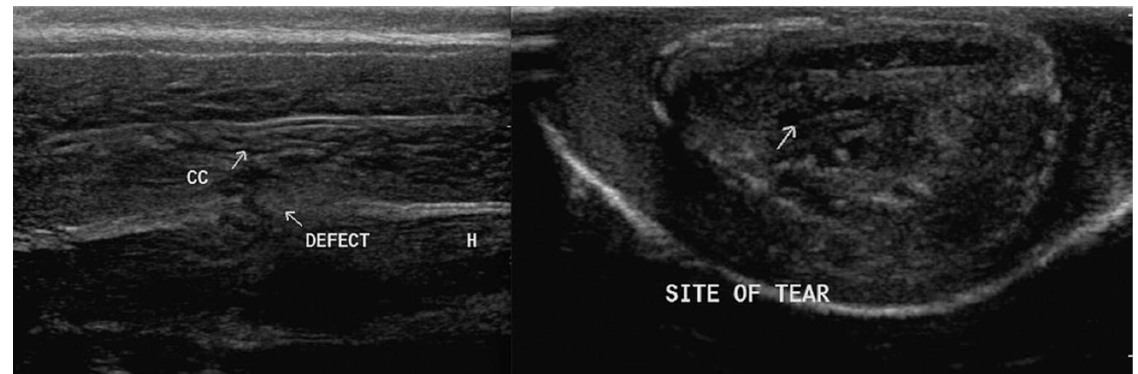
Fig. 2. Ultrasound Finding of Penile Fracture. Adapted from Chahal et al . [19]. Copyright BMJ Publishing Group. Reprinted with permission. Ultrasound images showing ventral haematoma (H) and defect in the wall of the right corpus cavernosa (CC).